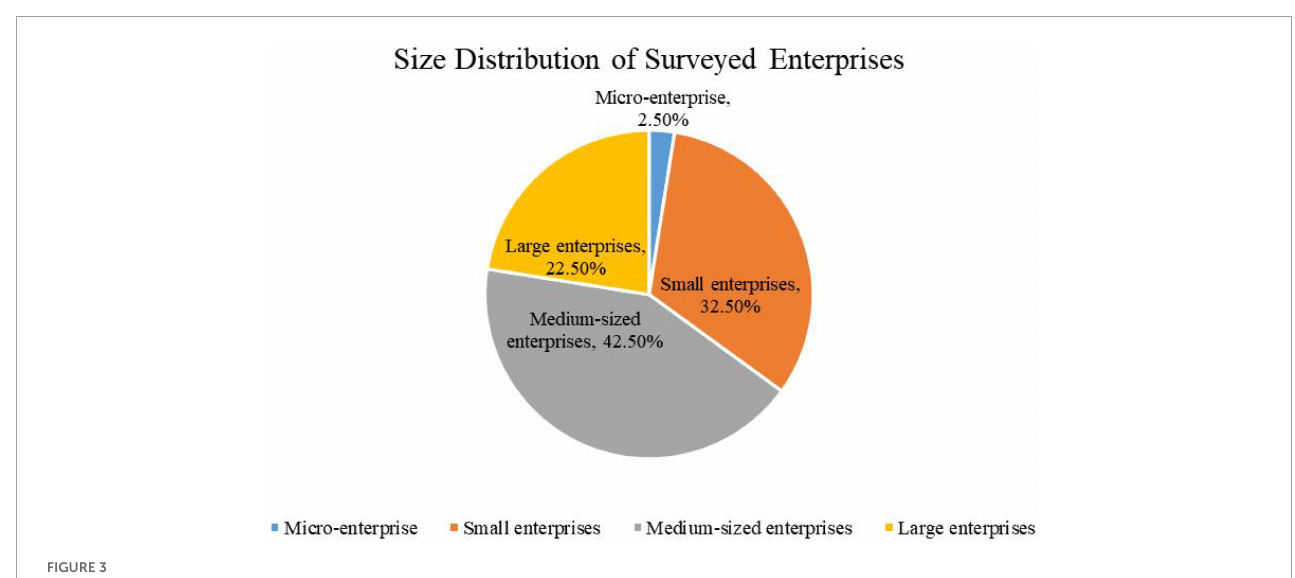
FIGURE2 Distribution of respondents by level in enterprises.